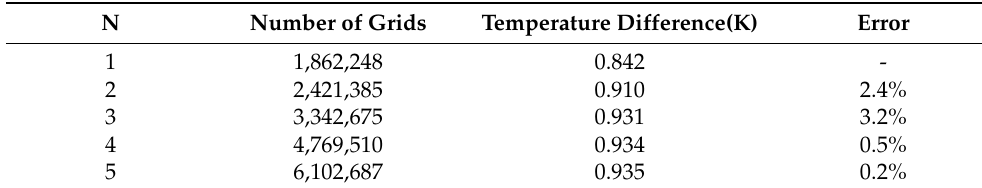
Table 4. The variation of temperature difference with the grid